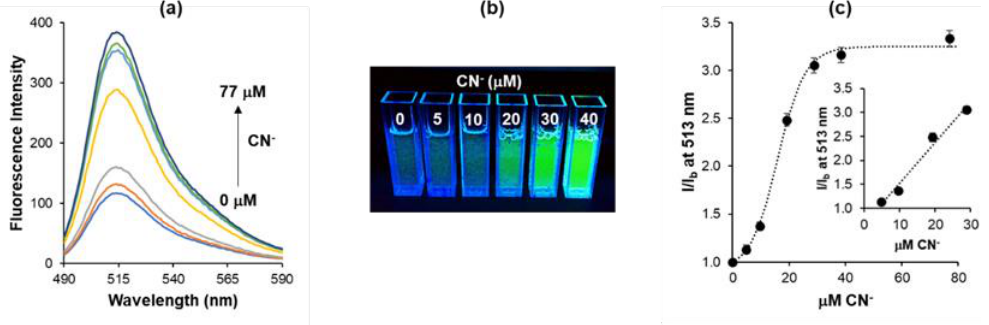
Figure 9. ( a ) Fluorescence emission spectra of a 0.2 µ M 2 + 0.1 µ M 3 + 16 µ M Cu 2 + mixture upon addition of increasing concentrations of CN − (0–77 µ M) in aqueous solution. ( b ) Photograph of aqueous mixtures containing 0.2 µ M 1 + 0.1 µ M 3 + 16 µ M Cu 2 + as a function of increasing CN − levels. ( c ) Fluorescence recovery (I / I b ) of a 0.2 µ M 1 + 0.1 µ M 3 + 16 µ M Cu 2 + mixture upon addition of CN − .